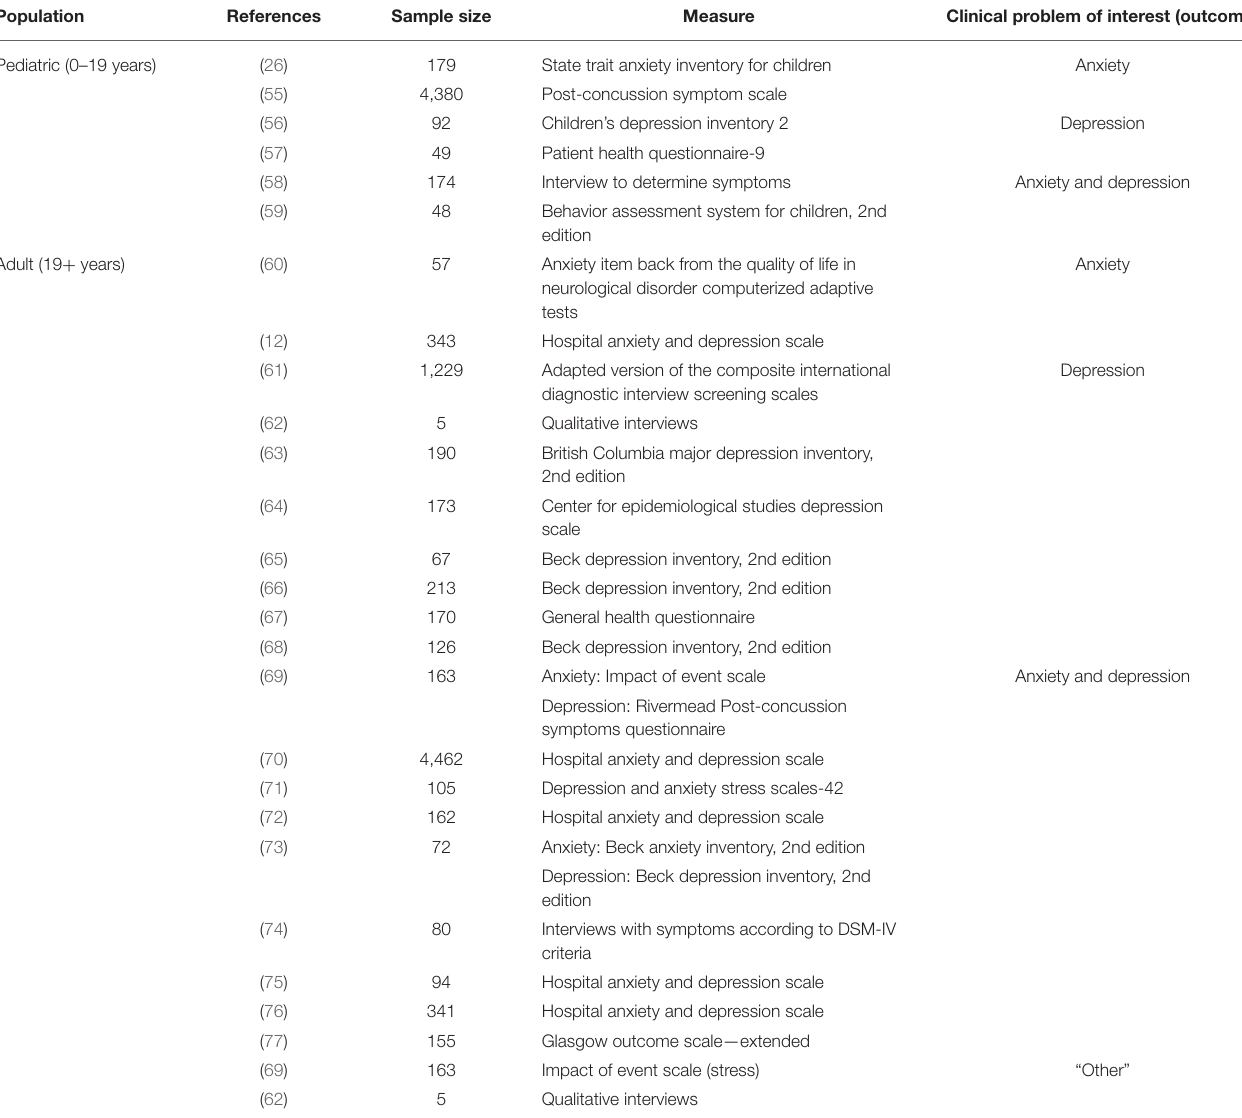
TABLE 1 | Outcome and assessment.